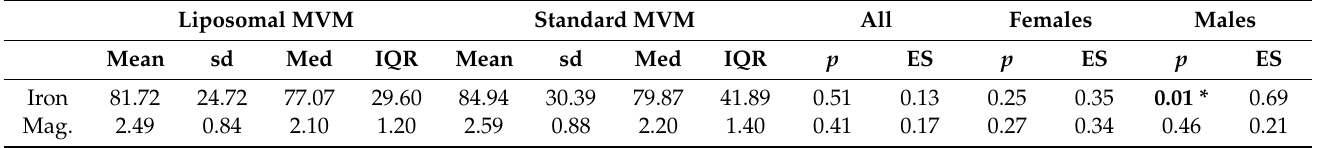
Descriptive data for each condition are presented for all participants. Units are mcg/dL for iron and mg/dL for magnesium; p -values were generated by a paired samples t-test or Wilcoxon signed-rank test, as appropriate (see text for details). Effect sizes (ES) correspond to Cohen’s d when paired sam- ples t -tests were performed and Wilcoxon r when Wilcoxon signed-rank tests were performed. “*”